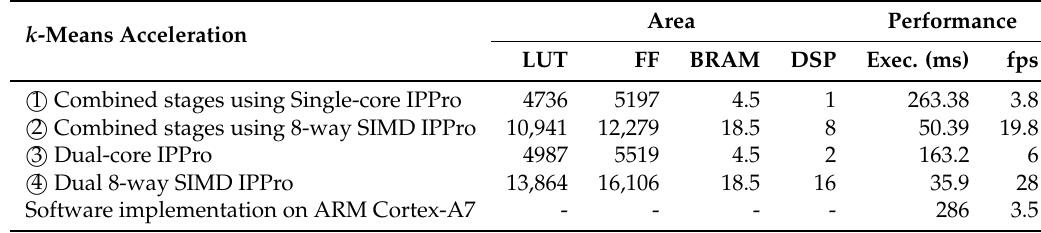
Table 8. Area utilisation and performance results of IPPro-based hardware accelerator designs in Figure 11 exploiting data and task parallelism namely 1 (cid:13) , 2 (cid:13) , 3 (cid:13) and 4 (cid:13) . k -Means